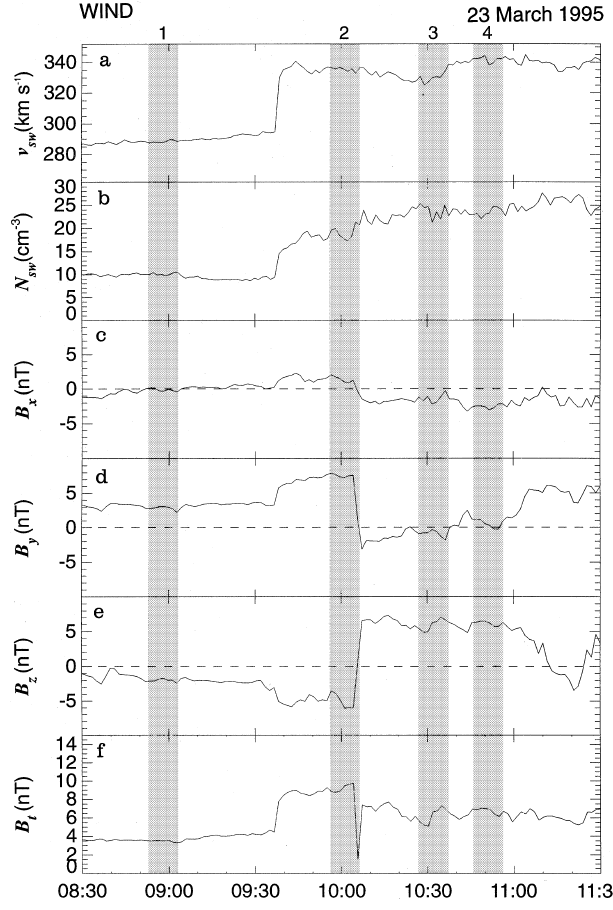
Fig. 2. Data from the WIND spacecraft for the interval 0830- 1130 UT on 23 March 1995, showing, from top to bottom , the solar wind plasma velocity, v components and magnitude of the IMF, B vertical grey stripes correspond to 10 min SuperDARN data intervals shown in